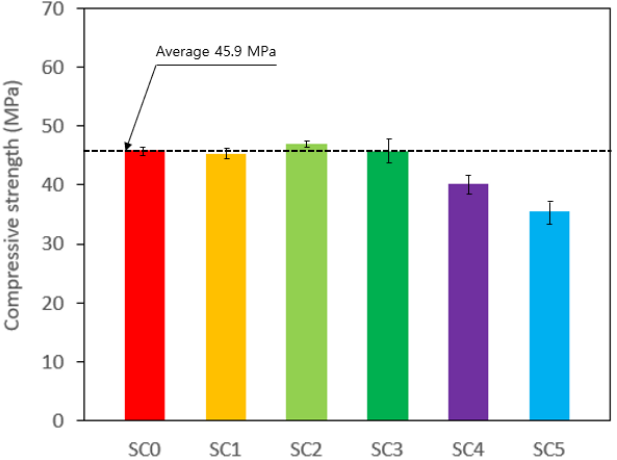
Figure 7. Compressive strength of MFRCM and HyFRCM versus PM.